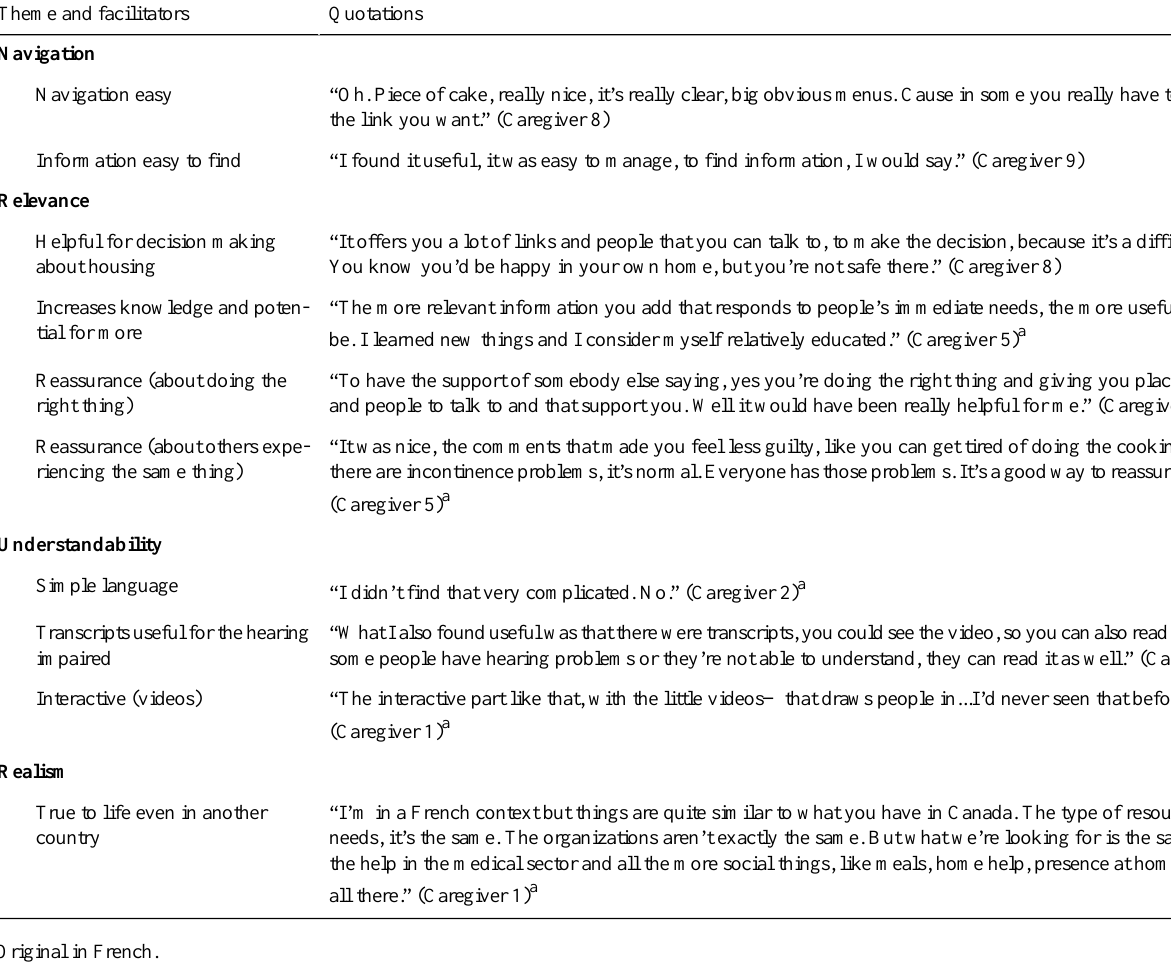
Table 2. Factors facilitating the use of the website and illustrative